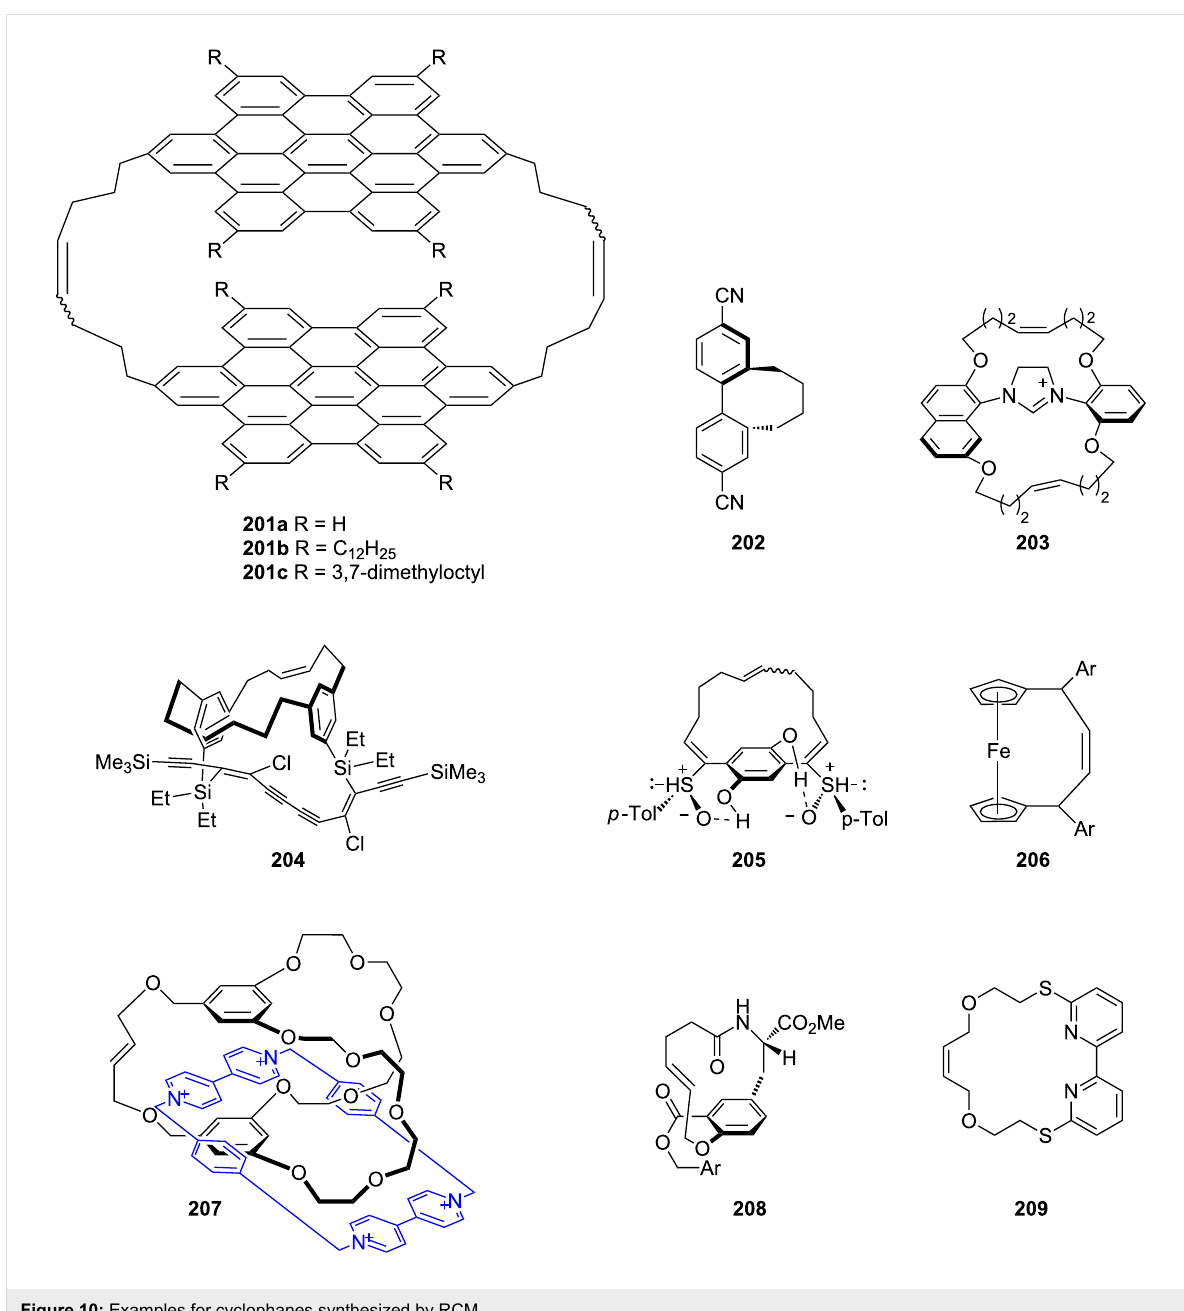
Figure 10: Examples for cyclophanes synthesized by